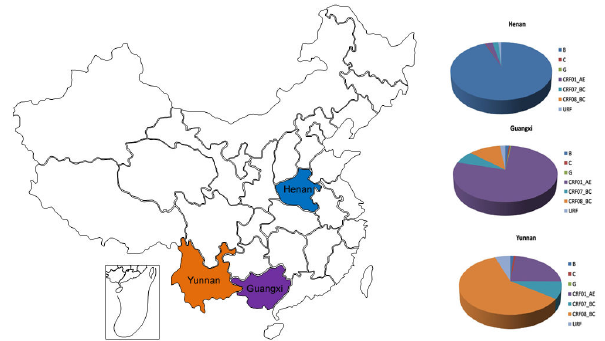
Figure 1. Geographical location of Henan, Guangxi and Yunnan provinces in China and frequency of HIV-1 subtypes. Map of China highlighting Henan, Guangxi and Yunnan provinces were listed in the Left. HIV-1 subtypes were determined by the NCBI viral genotyping tool and phylogenetic analyses, as described in Materials and Methods. The frequencies of HIV subtypes in three provinces were graphied separately in the right column.